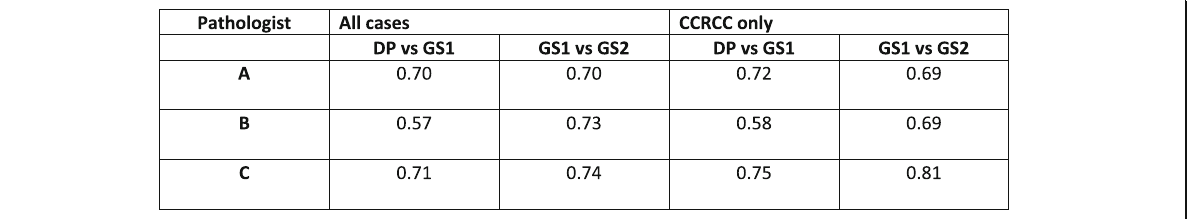
Fig. 1 Cohen ’ s Kappa agreement for individual pathologists between DP and GS read 1 and for GS read 1 and GS read